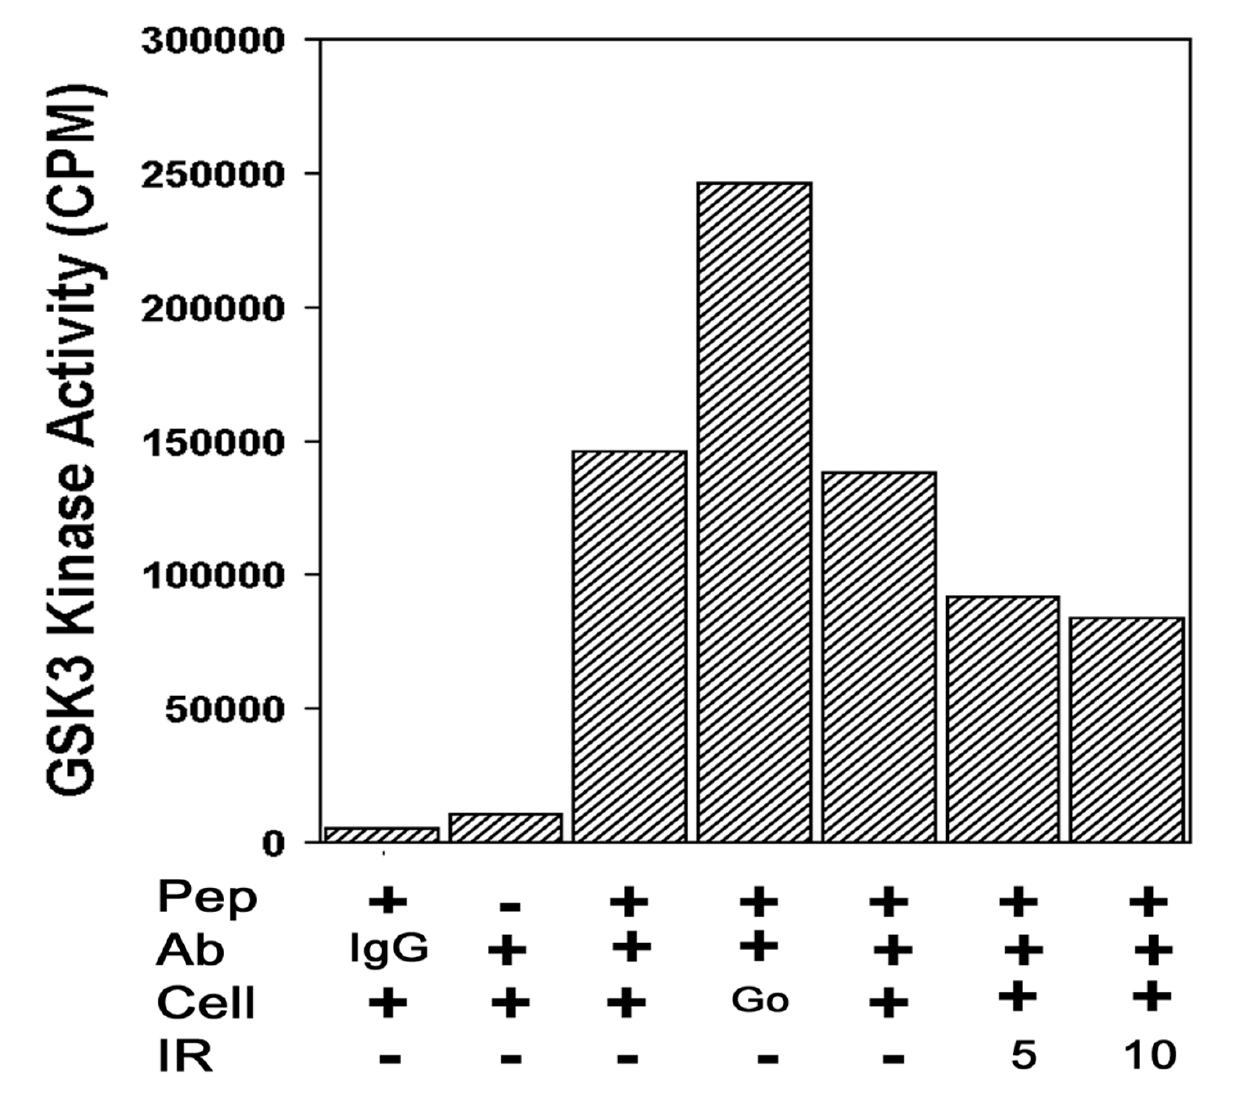
Figure 4 Ionizing Radiation inhibits GSK3 β kinase activity. SAOS-2 cells were immunoprecipitated with anti-GSK3 antibody and incubated with CREB phosphopeptide substrate. Total CPM incorporated into the substrate peptide are shown. Pep: Assays carried out with or without peptide. Ab: Immunoprecipitation carried out with either IgG or anti-GSK3 antibody (+). Cell: Cells were either growing asynchronously (+) or preincubated for 24 h in 0.5% Serum to induce quiescence (Go). IR: Cells were exposed to 5 or 10Gy of Ionizing Radiation and allowed to recover for 60